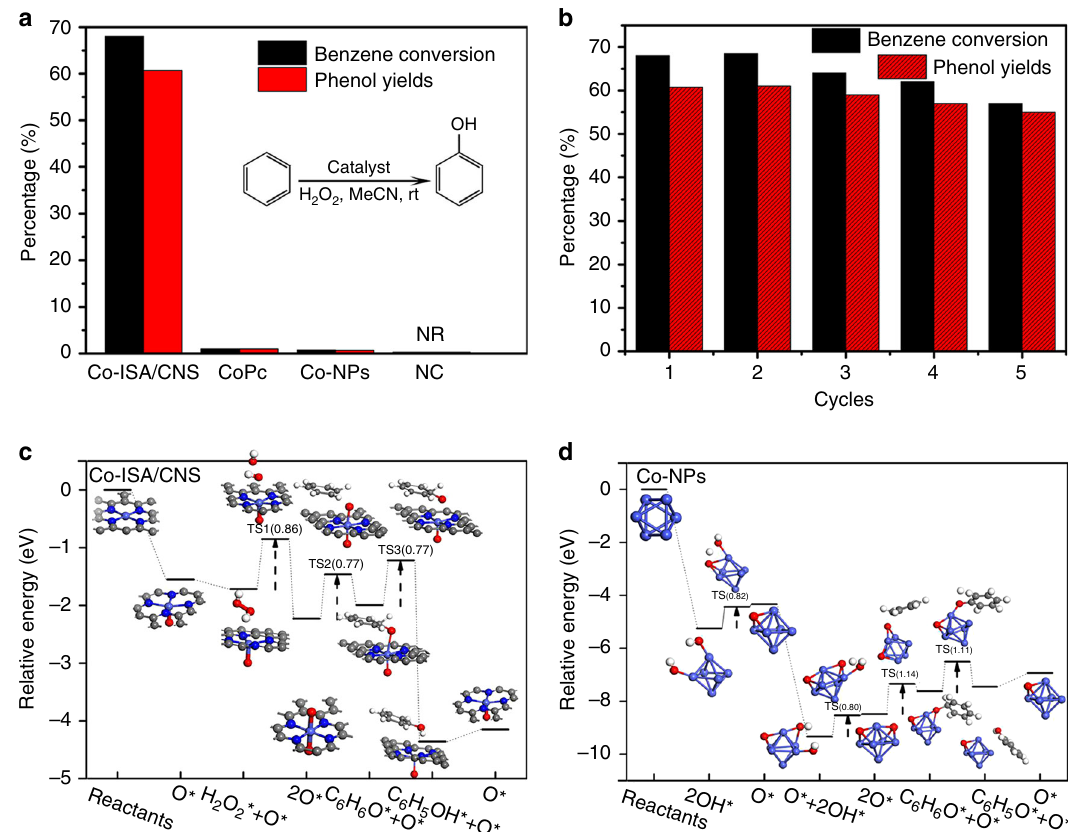
Fig. 4 Catalytic performance and proposed mechanism. a A comparison of benzene oxidation catalyzed by the Co-ISA/CNS catalyst, CoPc, Co-NPs, and NC. b Recycle performance of Co-ISA/CNS catalyst. c , d Proposed mechanism of H 2 O 2 activation and benzene oxidation by DFT calculations over Co-ISA/ CNS catalyst and Co-NPs,